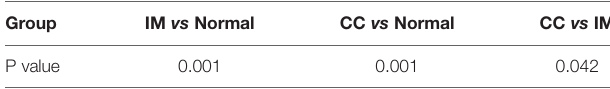
TABLE 2 | Beta diversity analysis and statistical analysis.